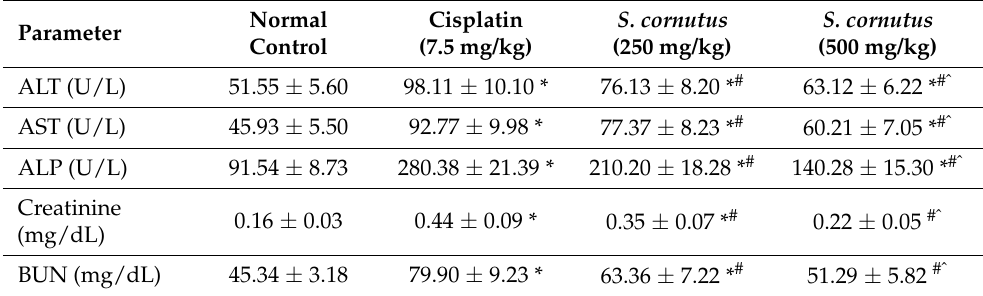
Table 4. The effect of S. cornutus crude extract on the liver and kidney functions in the experimental